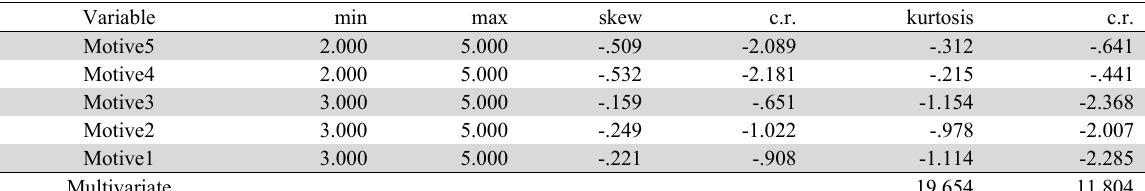
The results of the assessment